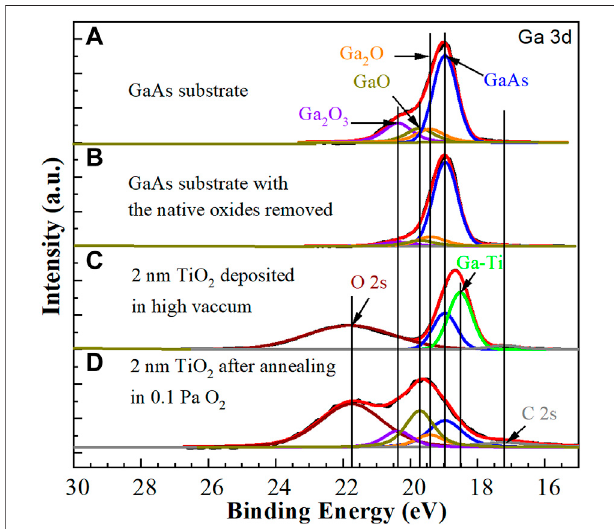
FIGURE 5 | XPS core-level spectra of Ga 3d from (A) GaAs wafer; (B) GaAs substrate with native oxides removed; (C) TiO 2 (2 nm)/GaAs heterostructure without annealing; and (D) TiO 2 (2 nm)/GaAs heterostructure with annealing in 0.1-Pa O 2